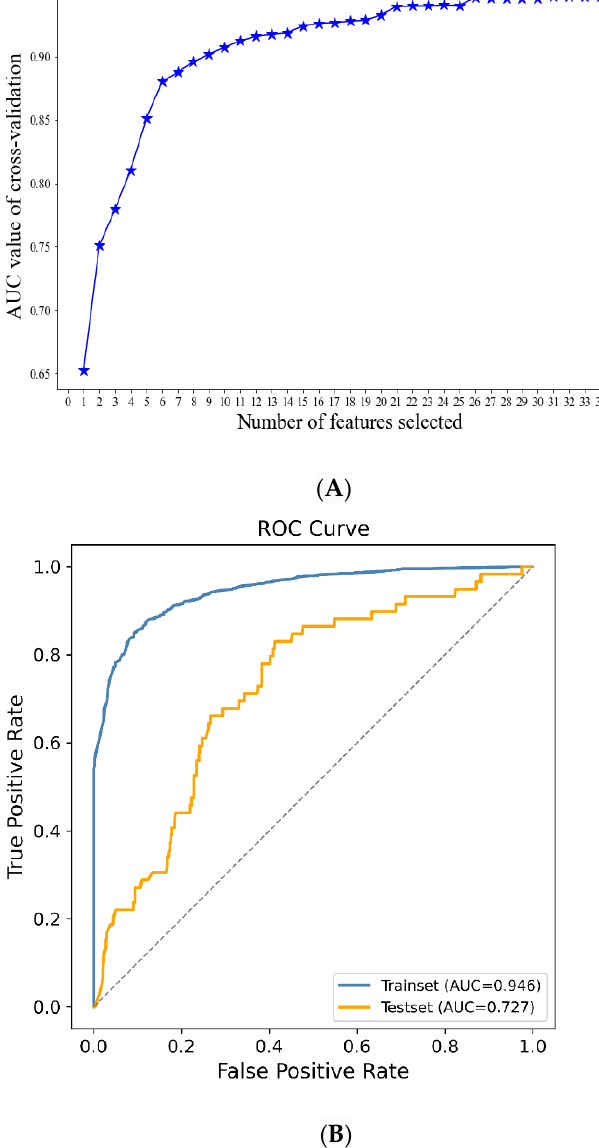
Figure 3. Using the RFE method to screen the optimal variables. ( A ) The most import variables, screened by the RFE method; ( B ) The receiver operating characteristic (ROC) curves of XGBoost model on the training set and testing set.